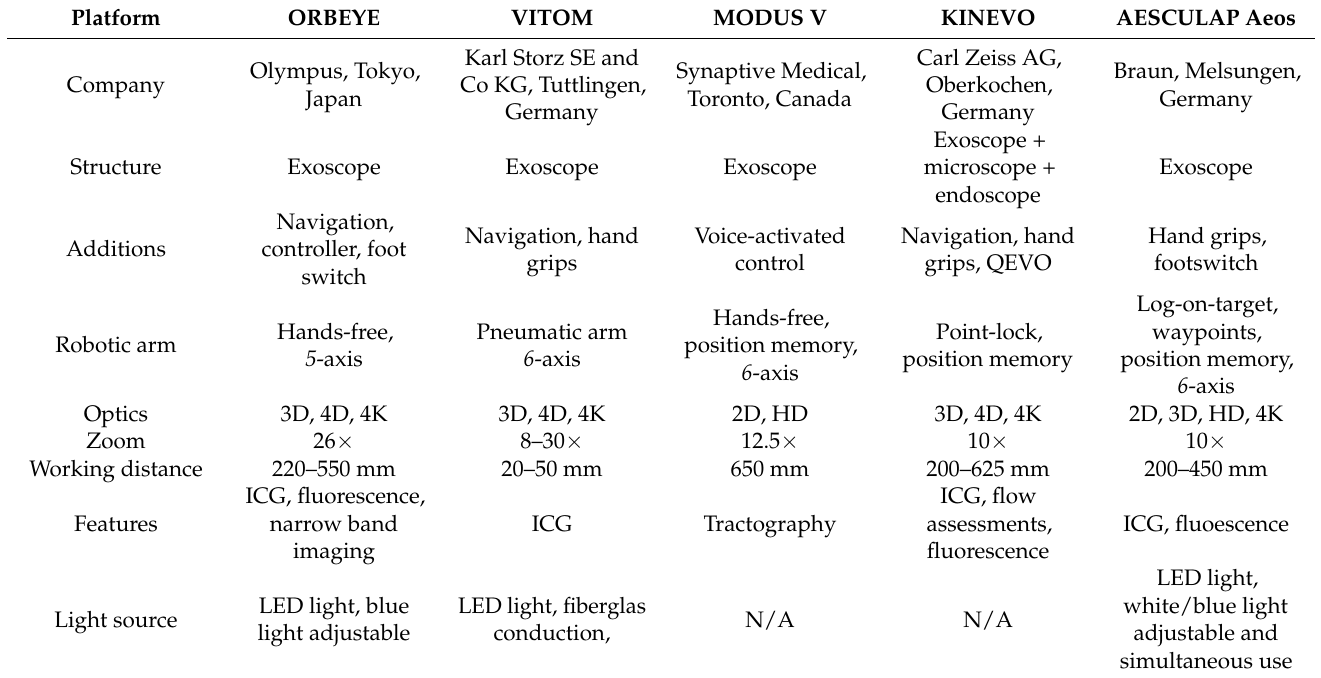
Table 1. The five different types of modern Exoscopes, including technical